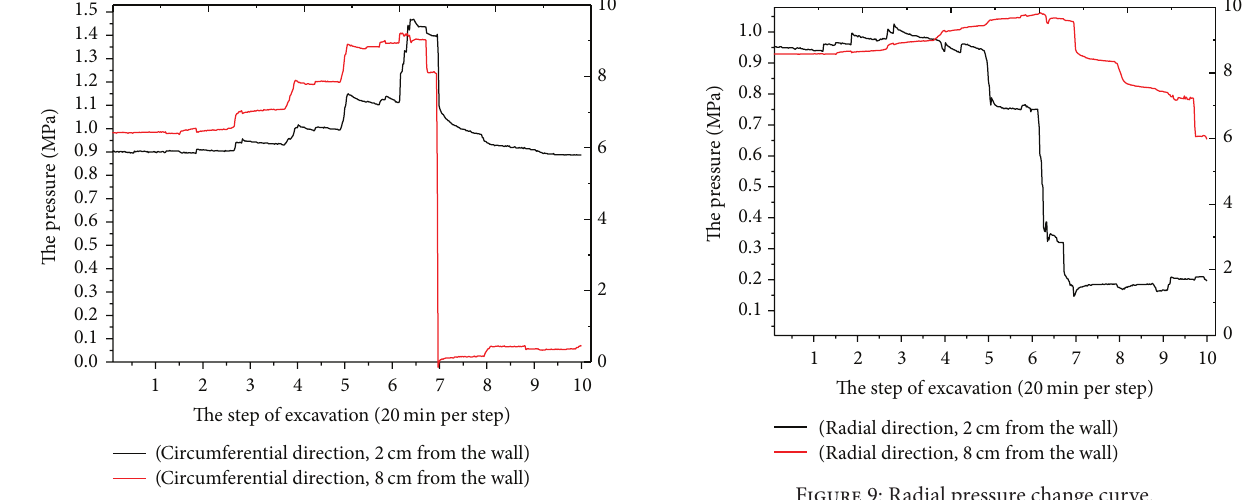
Figure 9: Radial pressure change